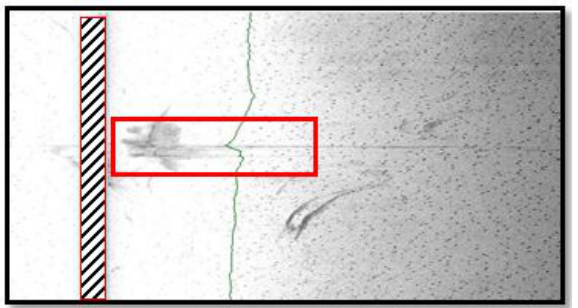
Figure 2. The backscatter image of snag buried in the river bed at upstream area (roughest